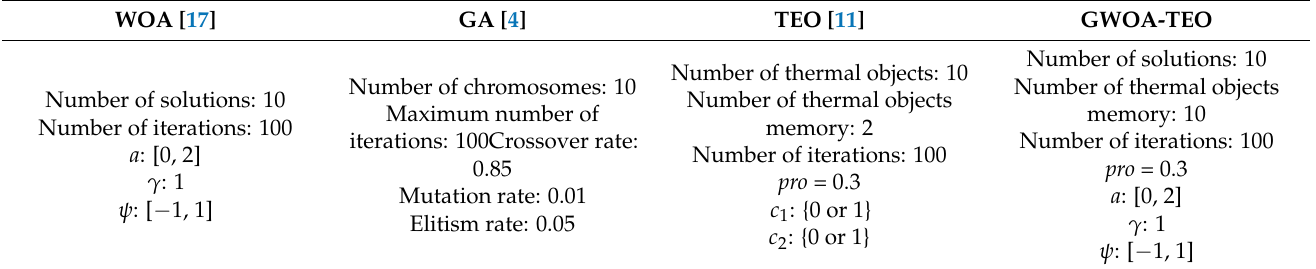
Table 5. Parameter setting of the algorithms of case study